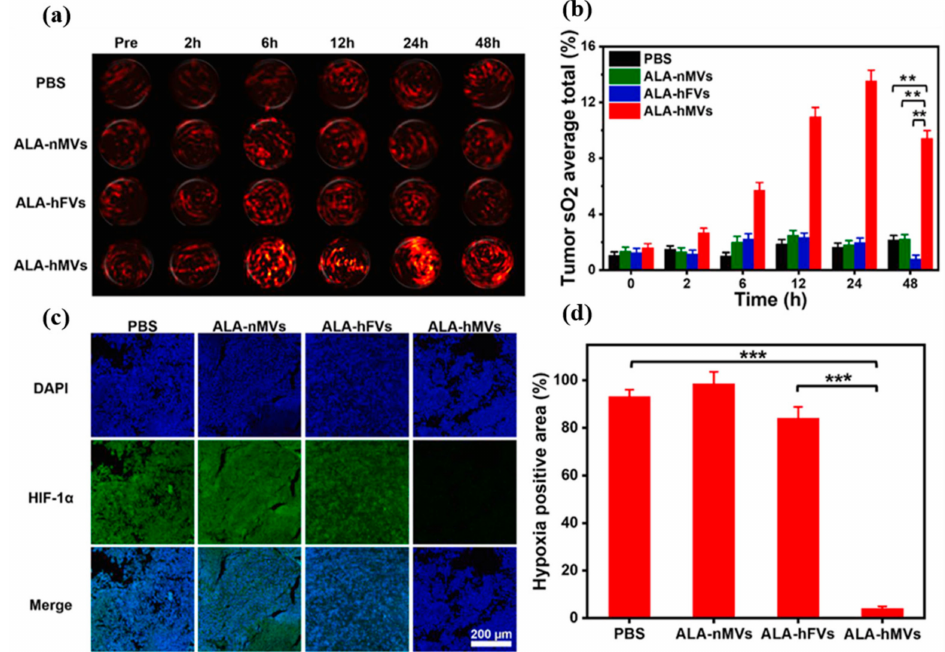
Figure 6. ( a ) Representative PA images of B16 tumors on mice showing signals of oxygenated hemoglobin ( λ = 850 nm) before/after i.v. injection of various formulations. ( b ) The corresponding quantification of the tumor vascular saturated O 2 levels (sO 2 ) calculated from ( a ). ( c ) Immunofluo- rescence staining of tumor sections showing the expression of HIF-1 α after i.v. injection of various formulations ( d ) Quantitative analysis of HIF-1 α positive areas for each group in ( c ) by using the ImageJ software ( n = 5). (*** p < 0.001, ** p < 0.01). Reproduced with permission [108]. Copyright 2021, Elsevier